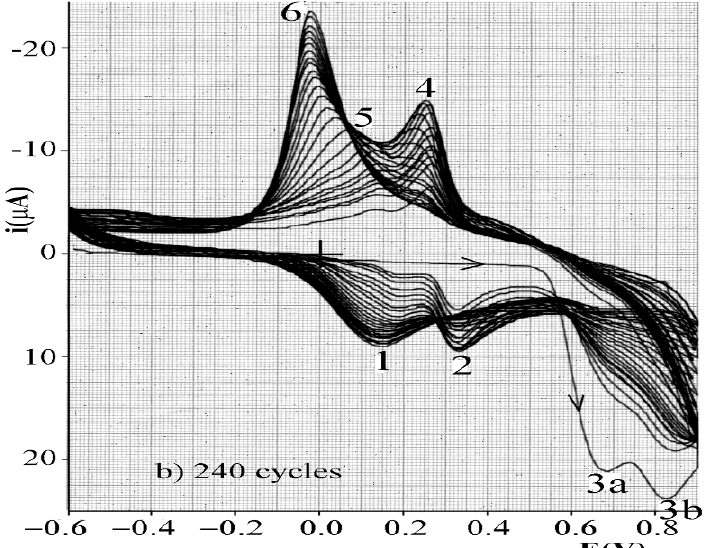
Figure 3. Cyclic voltammograms of 1×10 -3 mol L -1 oAP in 1 mol L -1 HClO completed after 240